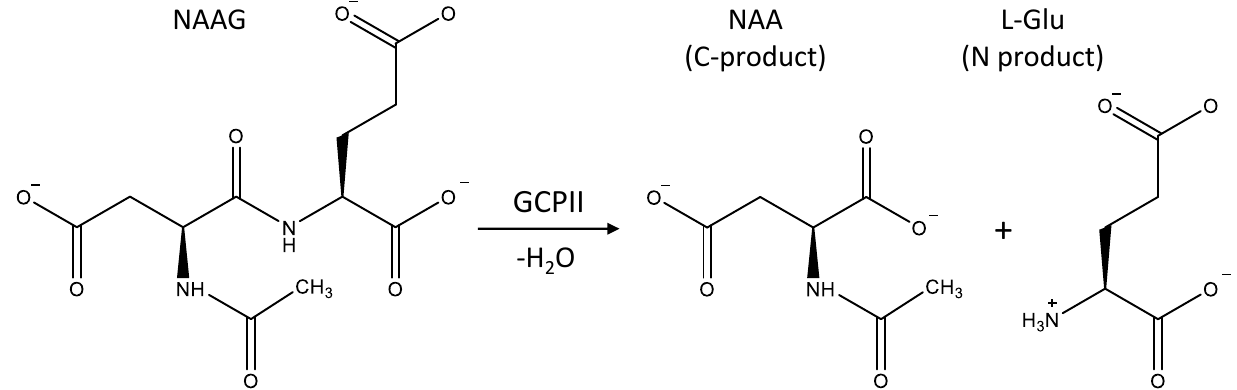
Figure 1. The hydrolysis reaction of N -acetyl- L -aspartyl- L -glutamate (NAAG) to the C-product, N -acetyl- L -aspartate (NAA), and the N-product, L -glutamate ( L -Glu).